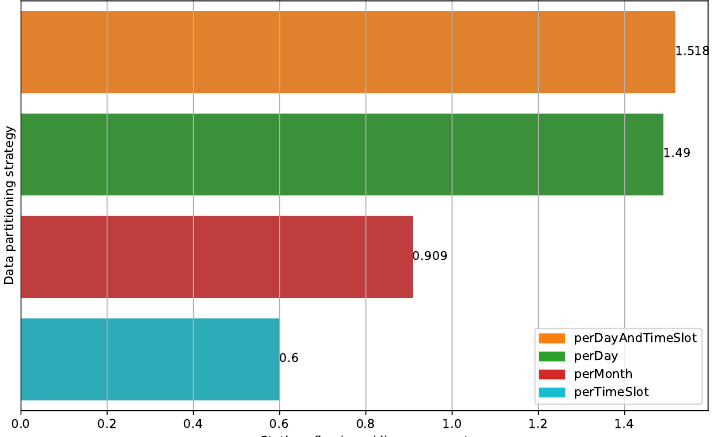
Figure 8. Reference configuration performances in terms of fixed stations per movement on different data partitioning